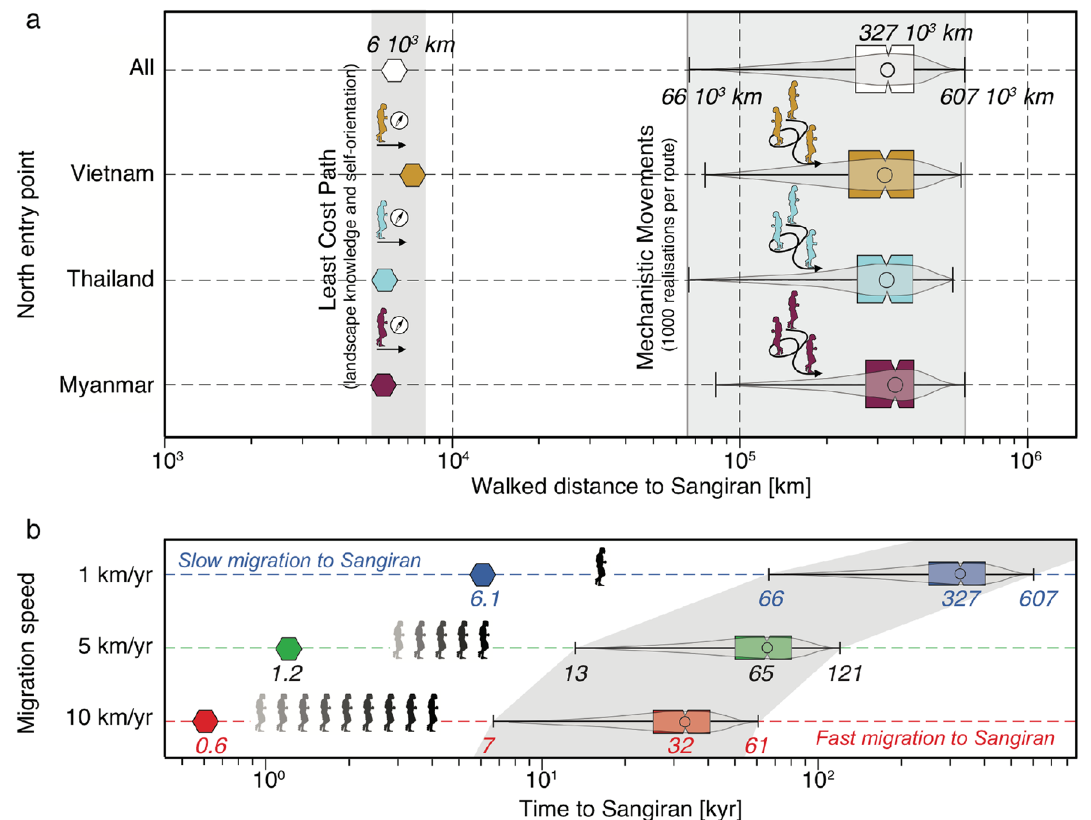
Figure 4. Travelled distance and time of H. erectus migration to Sangiran, statistical analysis (3000 simulations, 1000 per entry point - Myanmar, Thailand, and Vietnam). ( a ) Migration distance from the least-cost path (LCP) analysis and successful mechanistic movement realizations (Markovian random walk) for the three entry points, and all combined. ( b ) Travel times, for three dispersal speeds (slow: 1 km/yr 43 , medium: 5 km/year 44 , and fast: 10 km/yr 45